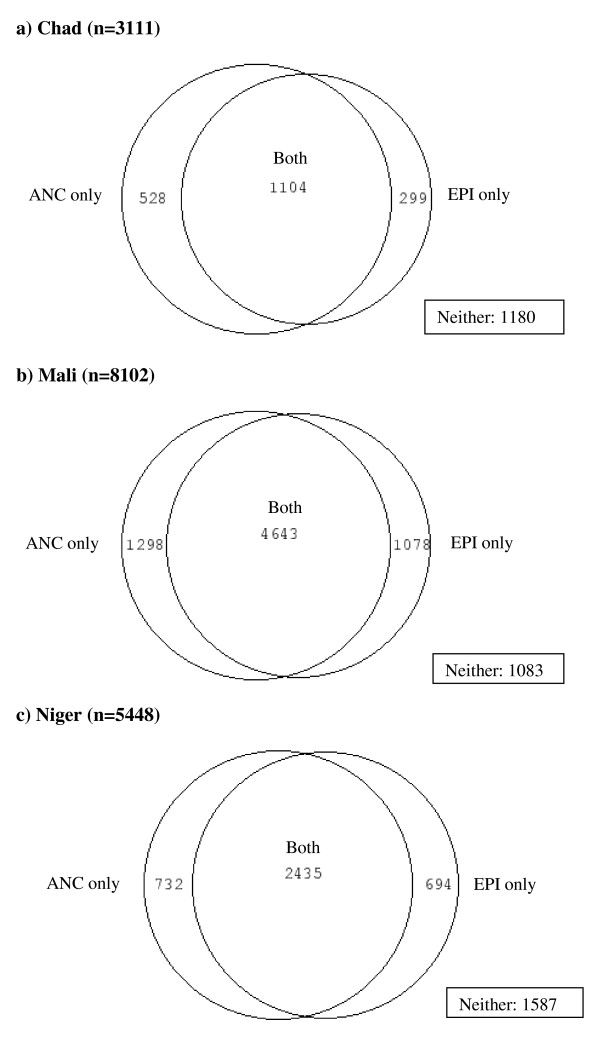
Venn diagrams of ANC and EPI attendance in a) Chad; b) Mali; and c) Niger.